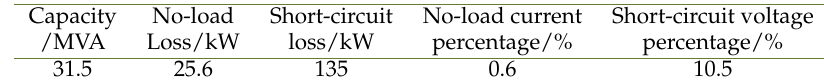
Table 2. Parameters of the main transformer